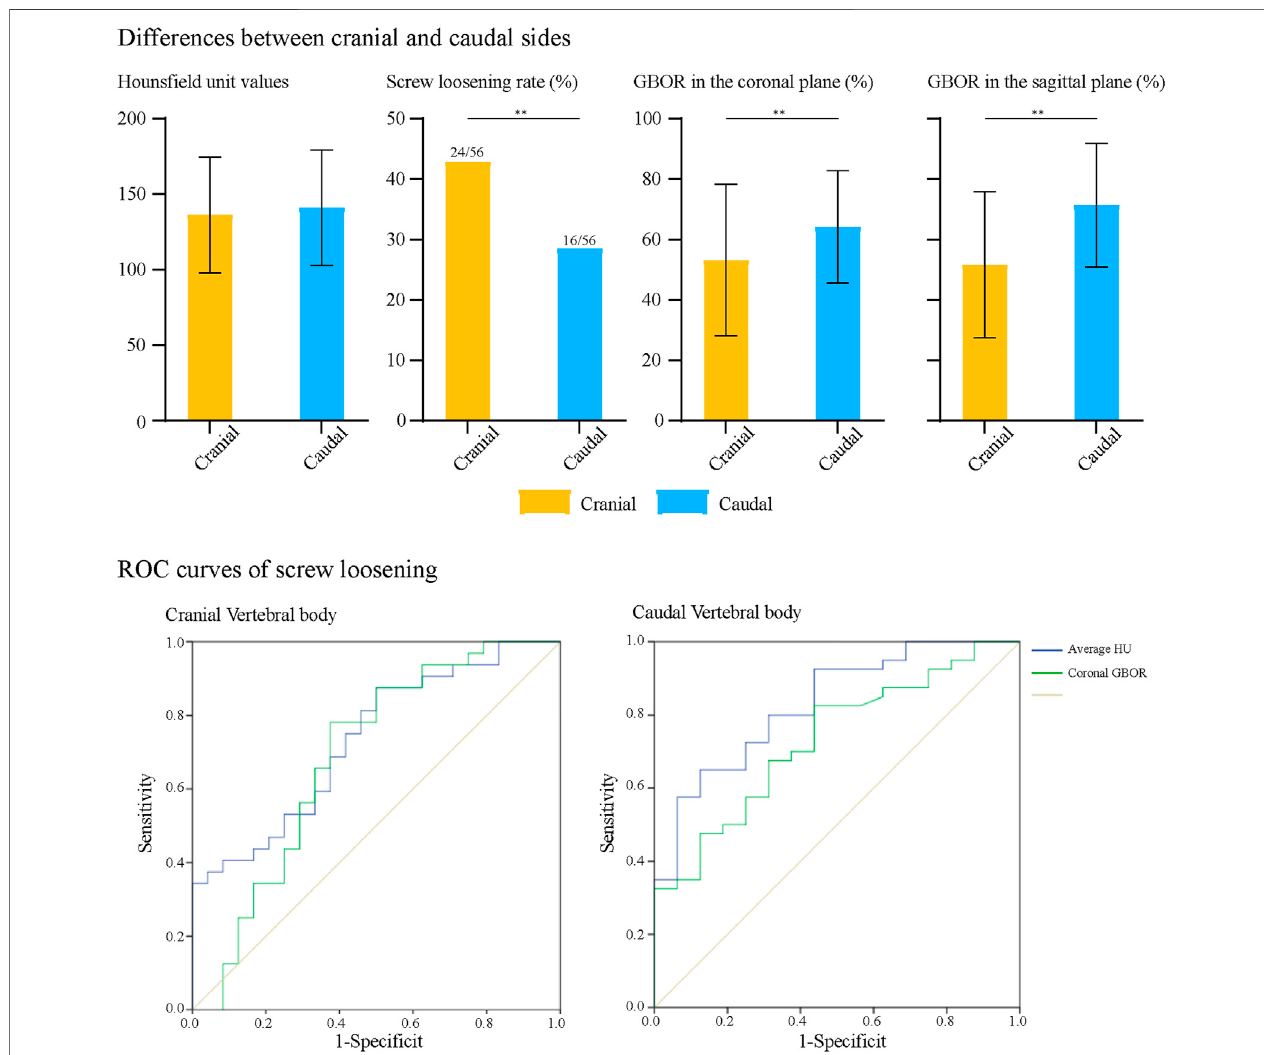
FIGURE 2 | ROC curves for cranial and caudal side screw